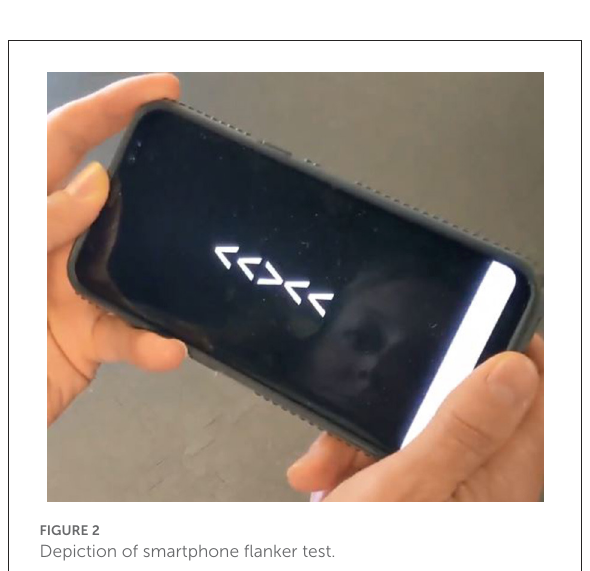
FIGURE2 Depiction of smartphone flanker